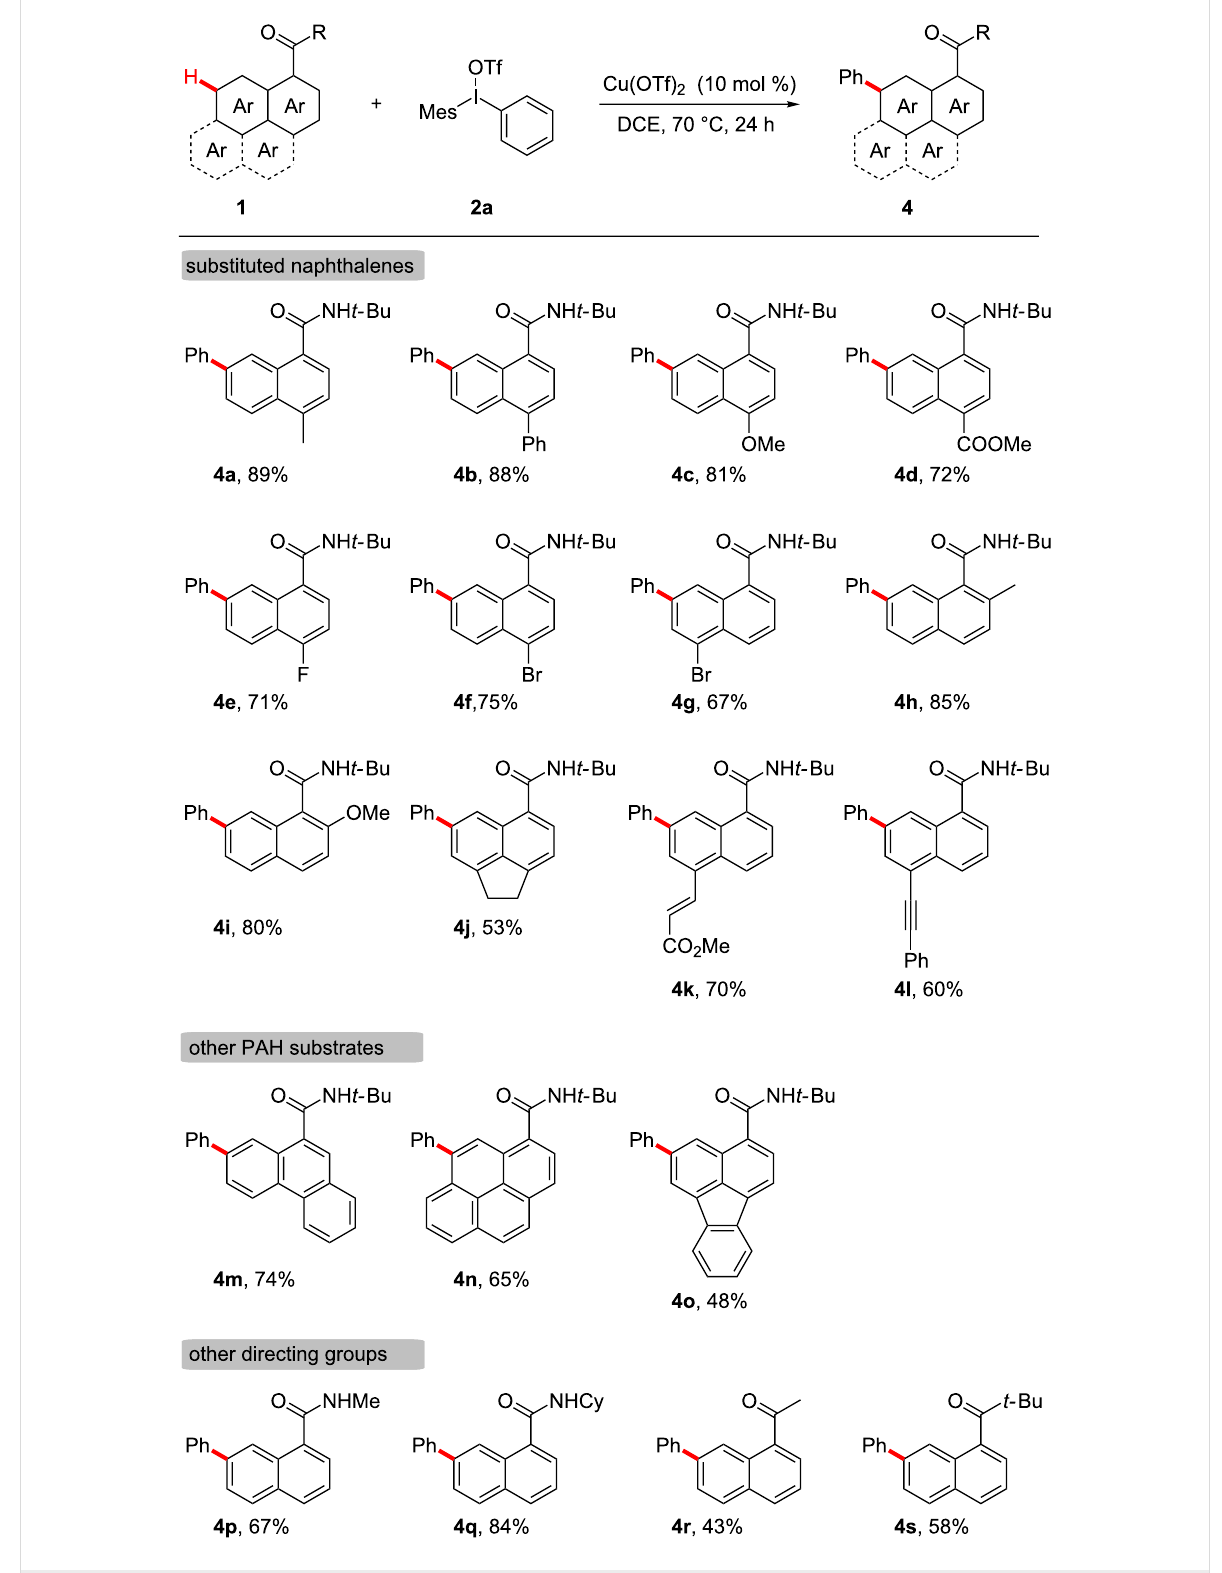
Scheme 3: Scope of PAHs. Reaction conditions: 1 (0.2 mmol), 2a (0.3 mmol) in DCE (1 mL) at 70 °C under N 2 for 24 h. Isolated yield. DCE = 1,2-